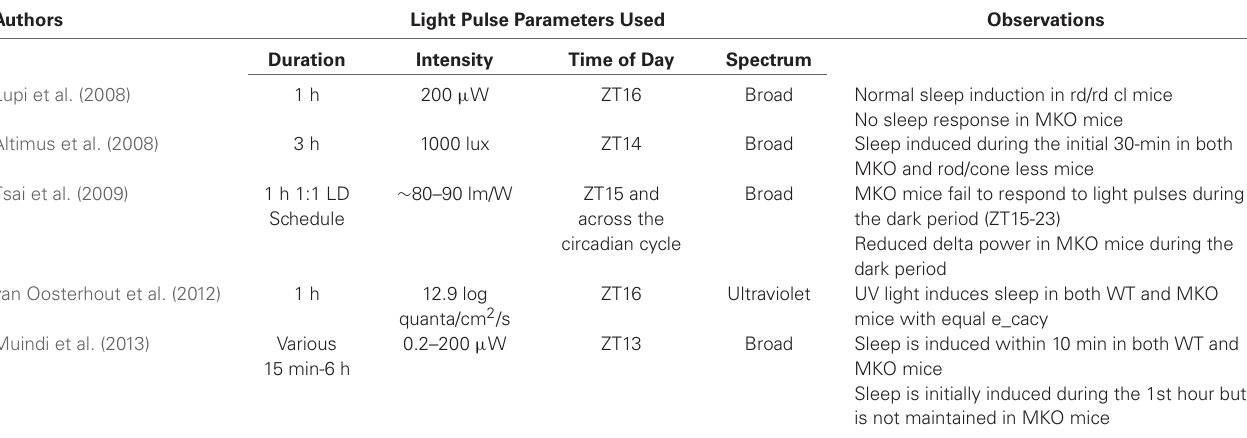
Table 1 | An overview of studies examining the role of melanopsin in the acute induction of sleep .